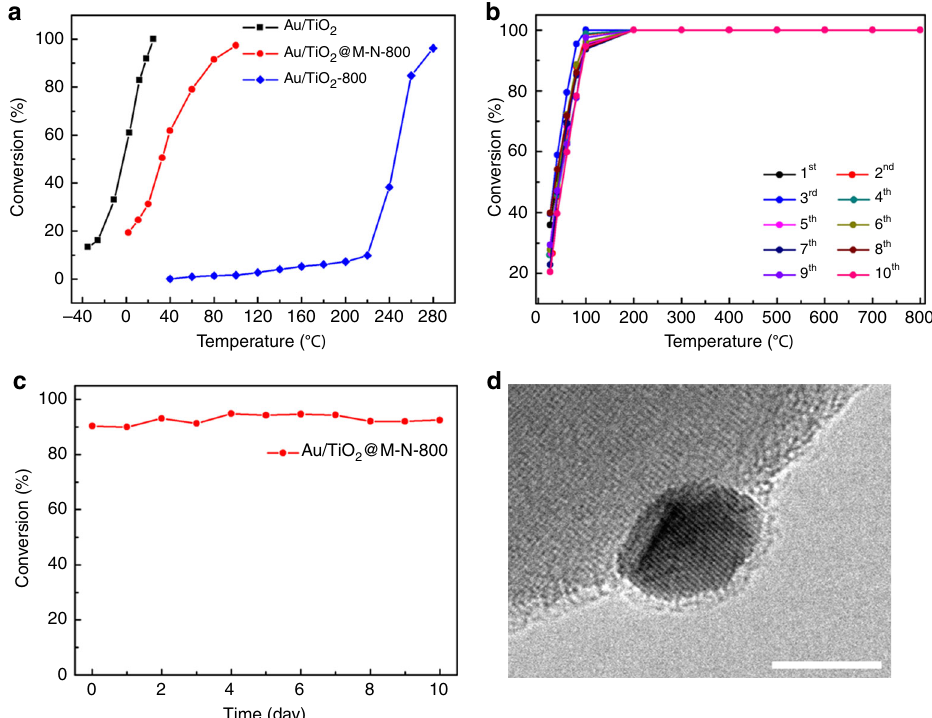
Fig. 5 Evaluation of Au/TiO 2 nanocatalysts in CO oxidation and simulated CO emission control reaction. a CO oxidation curves of Au/TiO 2 , Au/ TiO 2 @M-N-800 and Au/TiO 2 -800 with a feed gas comprising 1 vol% CO/ 1 vol% O 2 / 98 vol% He at 33.3 mL min − 1 . b Conversion of CO from 0 to 800 °C with 1st-10th cycles on Au/TiO 2 @M-N-800 catalyst for ten ignition-extinction cycles with a feed gas comprising 1 vol% CO/1 vol% O 2 /98 vol% He at 33.3 mL min − 1 . c Long-term simulated CO emission control reaction at 400°C on the Au/TiO 2 @M-N-800 with space velocity of 220 L h − 1 g cat − 1 . Reaction gas composition: 1.6 vol% CO, 1 vol% O 2 , 0.01 vol% propene, 0.00852 vol% toluene, 10 vol% water and balanced with He. d HRTEM image of Au/TiO 2 @M-N- 800 after simulated CO emission control reaction at 400 °C for 10 days. The scale bar corresponds to 5 Supplementary Table 3. To the best of our knowledge, it is the fi rst time to report that Au NPs can be encapsulated by titania